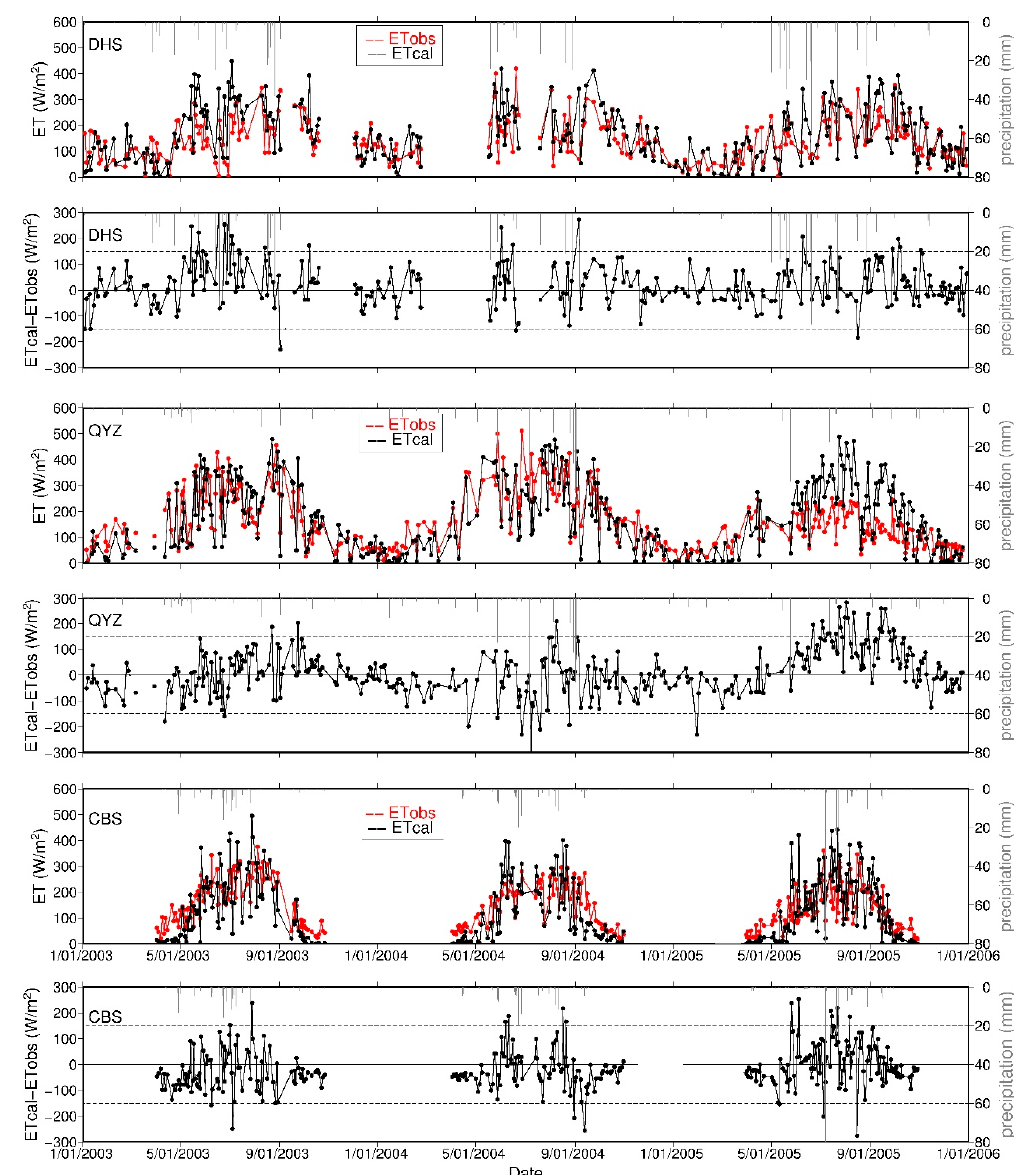
Figure 6. Time series of in-situ LE (LE obs ), estimated LE (LE cal ), and their di ff erences at three forest sites from 2003 to 2005. LE obs was averaged over 2 h around the satellite overpass. The dashed lines are ± 150 Wm − 2